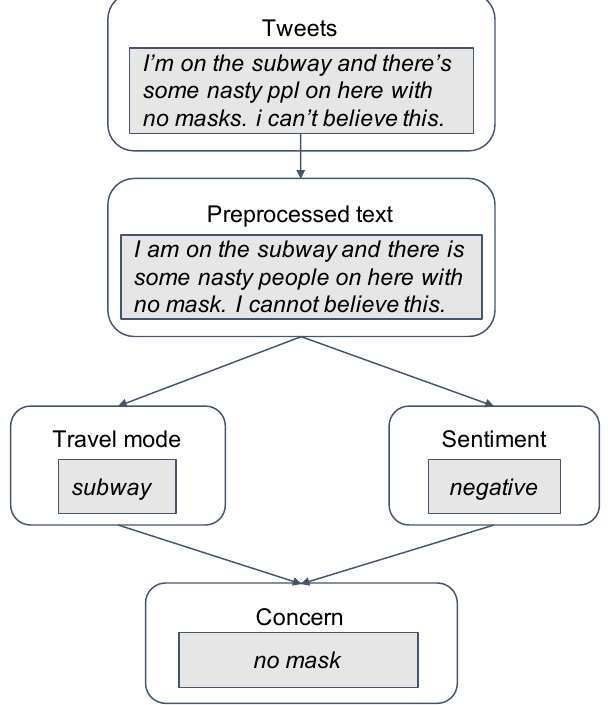
Figure 1. Work flow of text